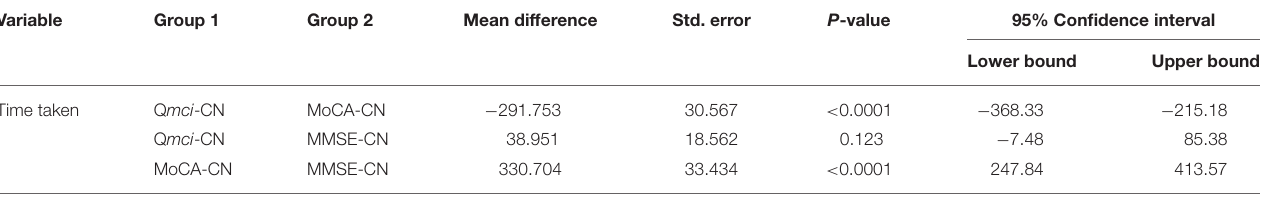
TABLE 3 | ANOVA Post-hoc pair-wise analysis comparing administration times for the Q mci -CN screen, MoCA-CN, and MMSE-CN. Variable